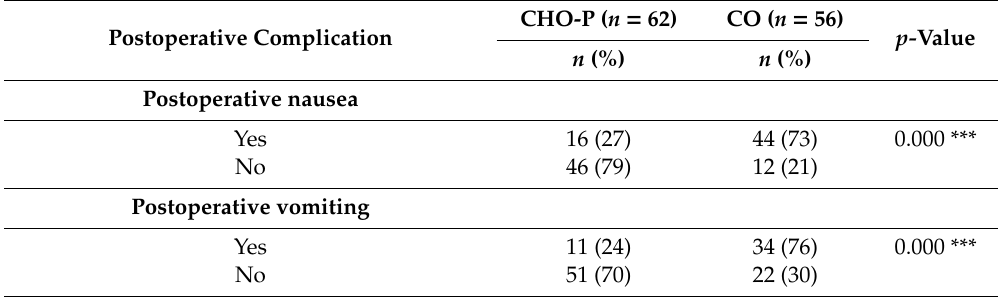
Table 6. Comparison of postoperative complications of surgical GC (gynecologic cancer) between intervention (CHO-P) and control groups